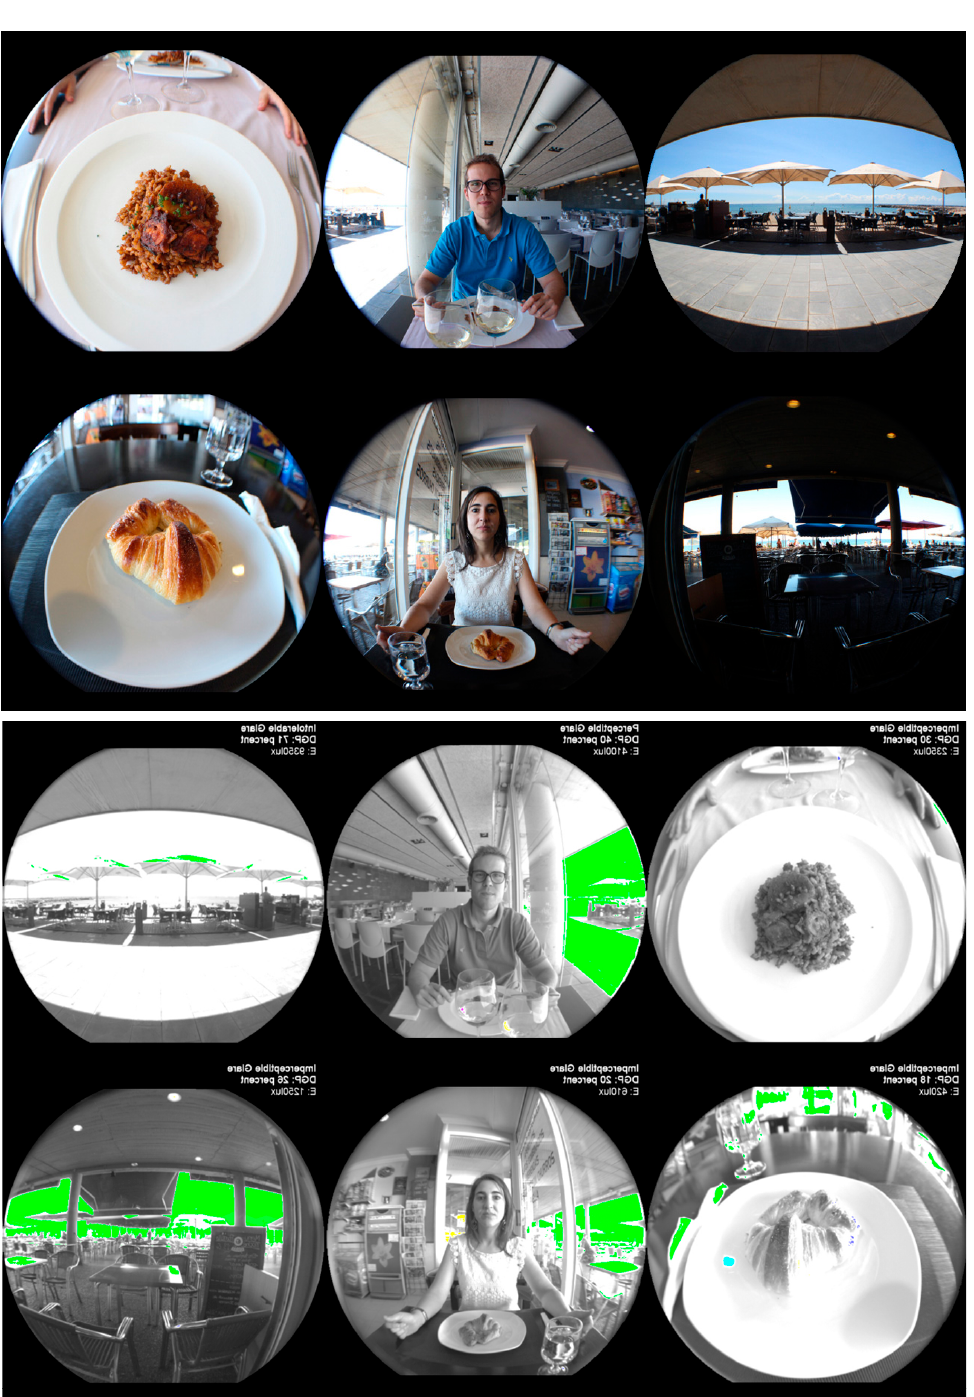
Figure 5. Pictures and results of the DGP index of each workplane picture using the Evalglare Radiance-based tool. ( top ) pictures; ( bottom ) results of Evalglare. Note that the tool is valid for illuminance higher or equal to 380 lx and the DGP index higher or equal than 0.2. Each picture has been tested adding measured vertical illuminance in lx (E), as an –i parameter. Colored surfaces in green are glare source surfaces. The tested photographs are HDR pictures obtained from WebHDR online software of Axel Jacobs [31].